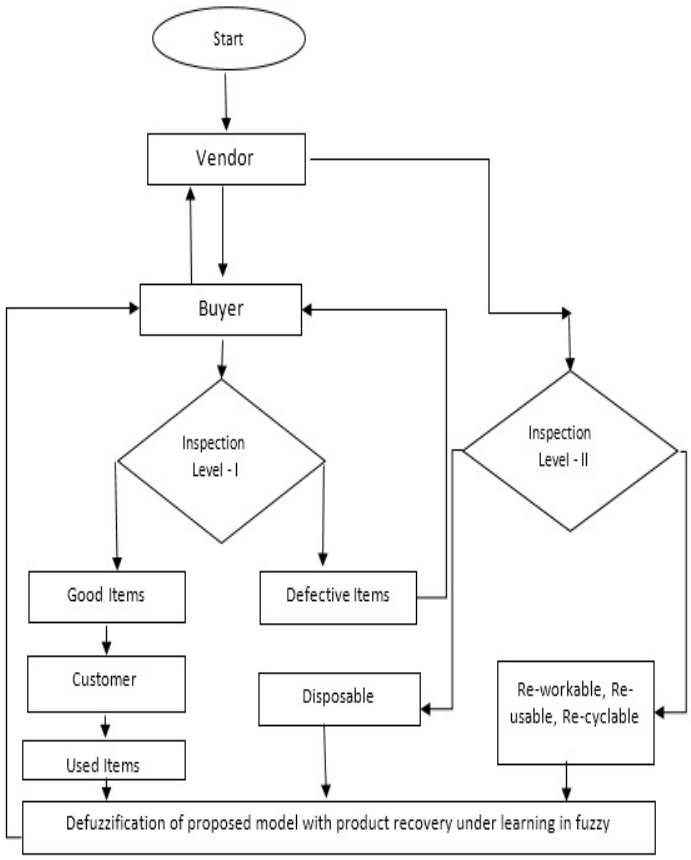
Figure 1. The activity of the vendor and buyer in a flowchart.